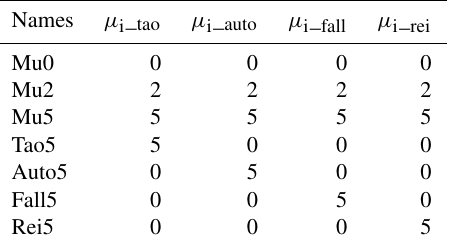
Table 2. The values of µ i in all experiments conducted in this